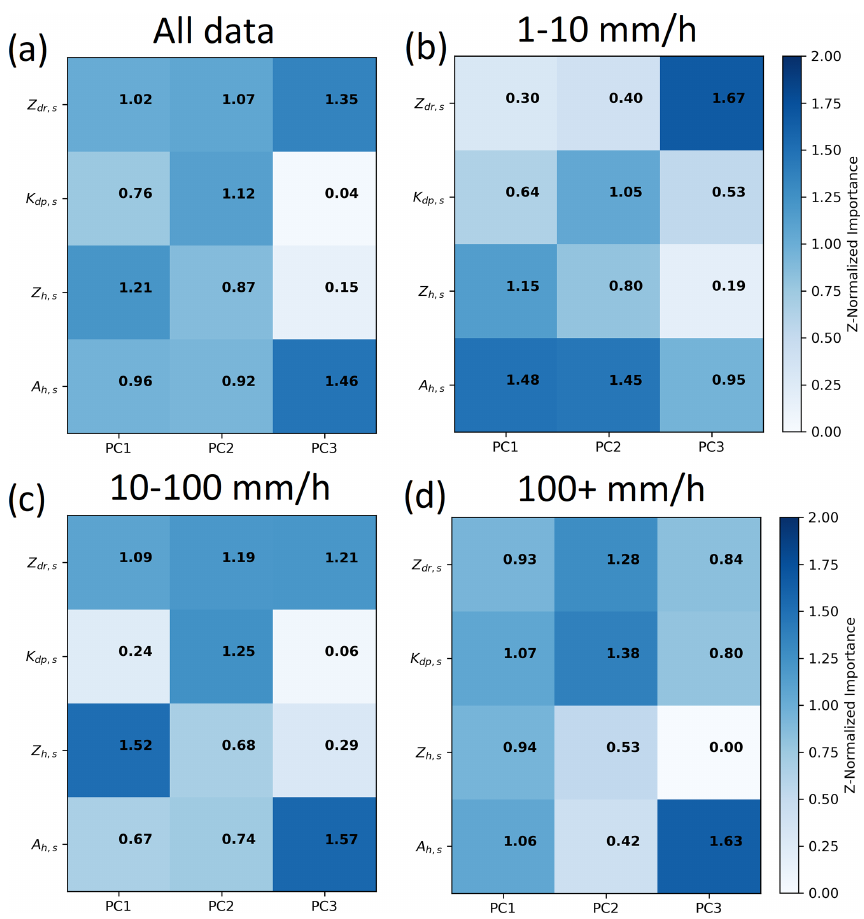
Figure 6. The variable importance matrix for the three principal components of X (a) when all data are considered, (b) when R is 1 to 10mmh − 1 , (c) 10 to 100mmh − 1 , and (d) more than 100mmh − 1 .